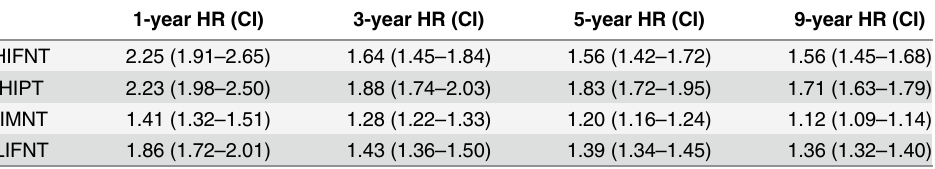
Table 7. Risk of death of trajectory phenotypes. HIFNT = High Intercept and Fast Negative Trajectory includes trajectory F. HIPT = High Intercept Positive Trajectory and includes trajectory A and B; IIMNT = Intermediate Intercept Mild Negative Trajectory and includes trajectory C, and D; LIFNT = Low Inter- cept Fast Negative Trajectory and includes trajectory E and G; Model adjusted for age, race, gender, for age, race, gender, diabetes mellitus, hypertension, cardiovascular disease, hyperlipidemia, peripheral artery dis- ease, cerebrovascular disease, chronic lung disease, hepatitis C, HIV, dementia, and eGFR at time of cohort entry (T0). Reference group is patients with stable kidney function before